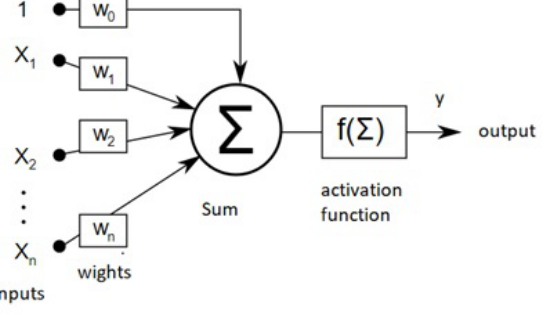
Figure 4. McCullotch-Pitts